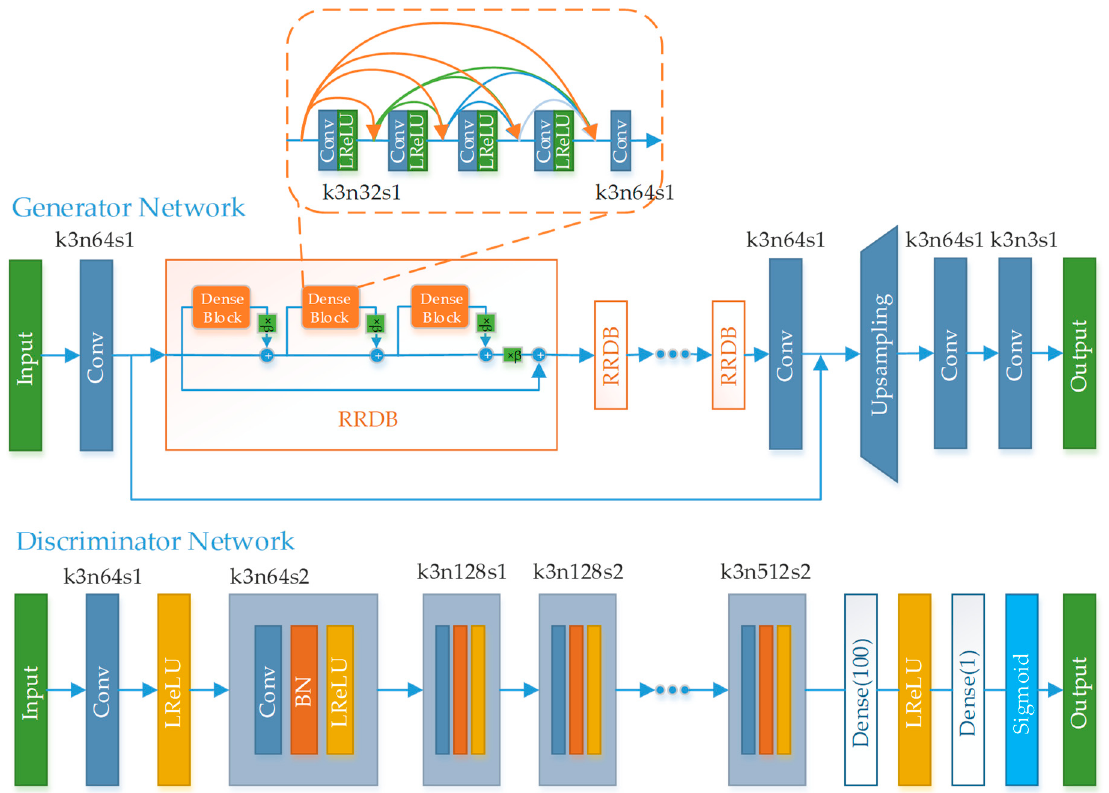
Figure 3. Architecture of the generative adversarial network (GAN)-based method with corresponding kernel size (k), number of feature maps (n), and stride (s) indicated for each convolutional layer. We used 23 residual-in-residual dense blocks (RRDBs) in the generator network and seven Conv-BN-LReLU blocks in the discriminator network. (Nomenclature: Conv–convolutional layers; LReLU–Leaky Rectified Linear Units [42]; BN–batch normalization [38]).